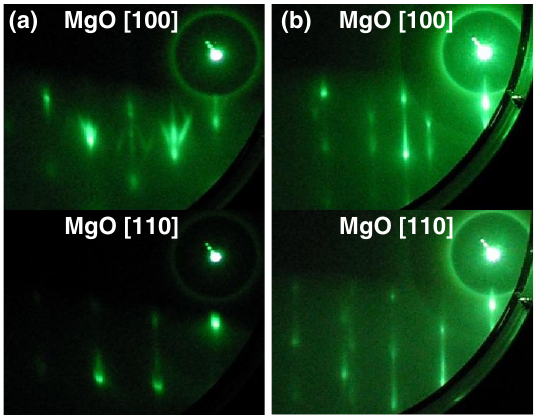
FIG. 2. RHEED patterns for (a) Nb(100)/MgO(100) and (b) Nb(110)/MgO(100) along the MgO[100] and MgO[110]